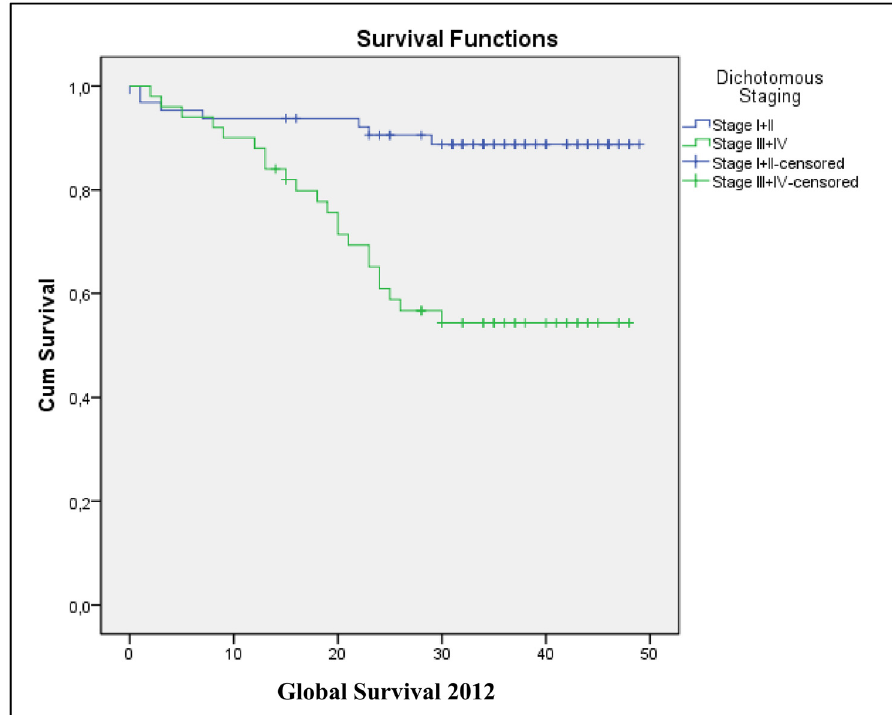
Fig 4. Kaplan-Meier GS curves according to tumor